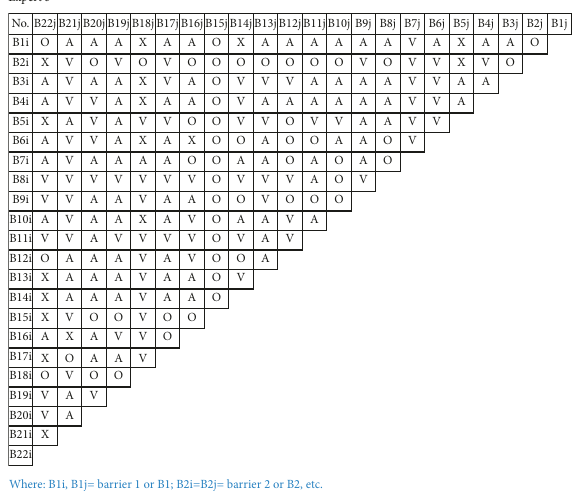
Table 7: ISSM from expert 4. etc.A Where: B1i, B1j= barrier 1 or B1; B2i=B2j= barrier 2 or B2,